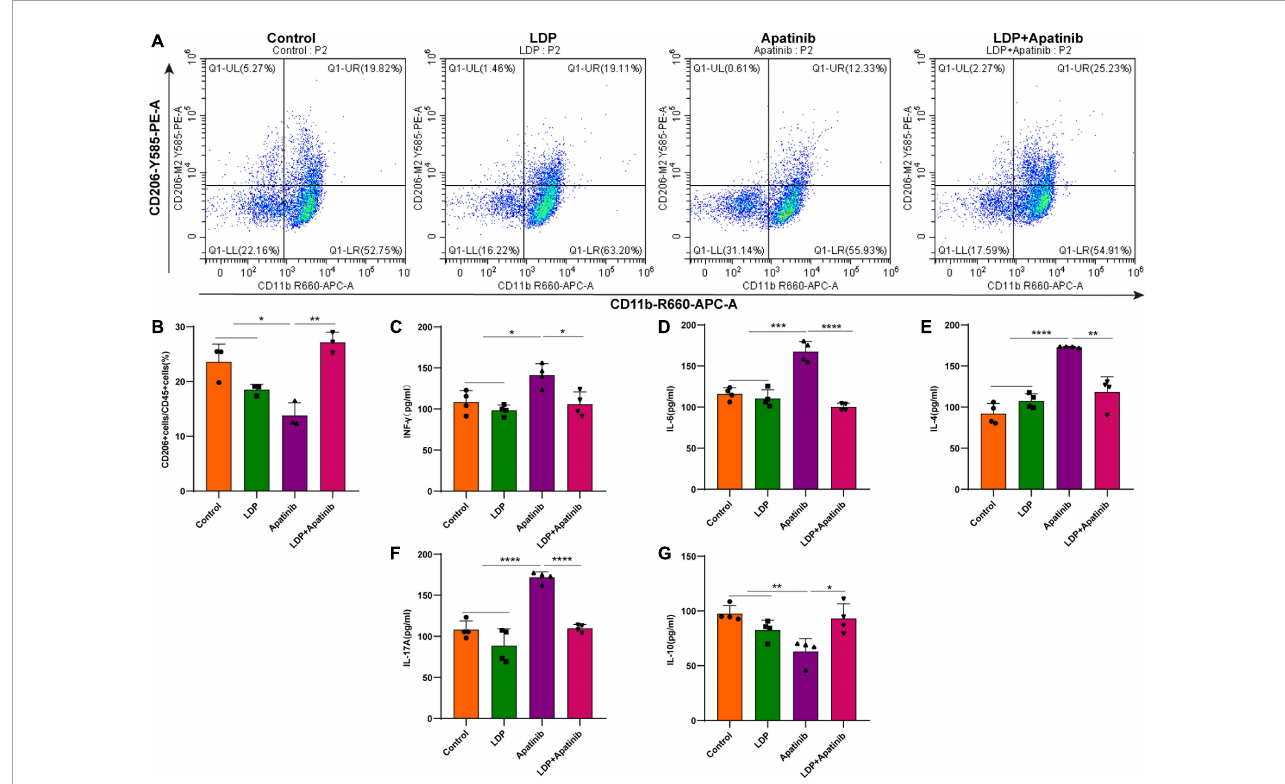
FIGURE4 In vivo Apatinib increases renal expression of pro-inflammatory factors and reduces the infiltration of M2 macrophages. (A,B) FACS analysis showed that macrophage M2 polarization for macrophages from control, LDP, apatinib, LDP + apatinib kidneys and quantitative analysis of four animals per group. (C–G) In renal extracts, cytokine levels were evaluated by ELISA of four animals per group. * p < 0.05, ** p < 0.01, *** p < 0.001, and **** P < 0.0001.